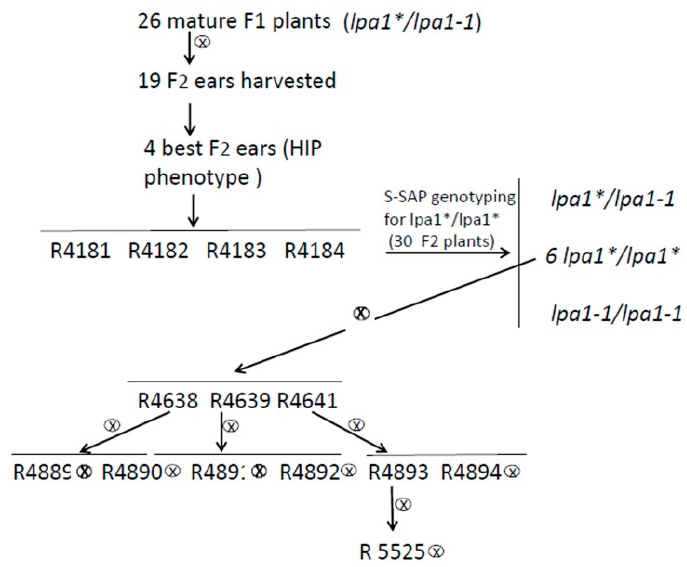
Figure 3. Scheme of the procedure used to obtain the NIL (Near Isogenic Line) lpa1-5525, homozygous for the new lpa1 mutation.